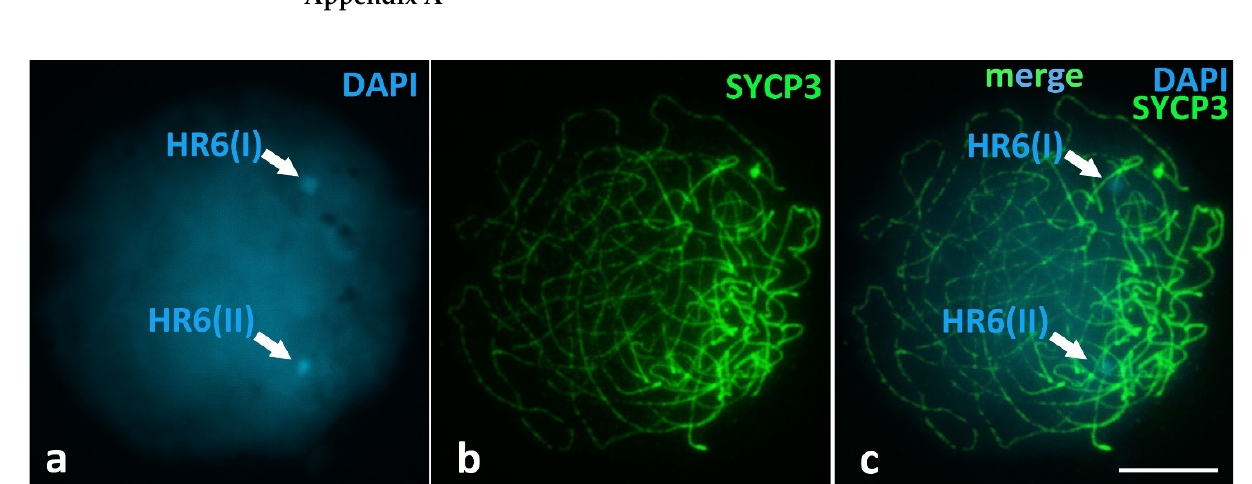
Figure A1. Chromosomal “bouquet” stage, V. berus spermatocyte I. Detection of the heterochromatin regions on the both chromosomes 6 before synapsis (HR6(I) and HR6(II)). ( a ) Chromatin stained with DAPI (blue), ( b ) Axial elements of chromosomes are immunostained with antibodies against the SYCP3 protein (green), and ( с ) merge. Bar—10 μ m.